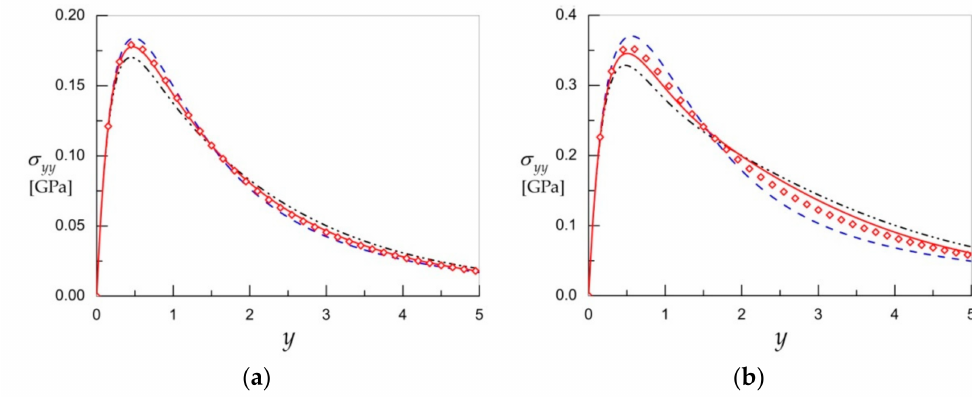
Figure 5. The thermal stress σ yy at x = 0 due to thermal field (26) for material 3 ( a ) and material 4 ( b ) under different values of N in formula for resolvent kernel (22): N = 1 (dash–dot lines), N = 2 (dash lines), N = 3 (solid lines), and exact solutions